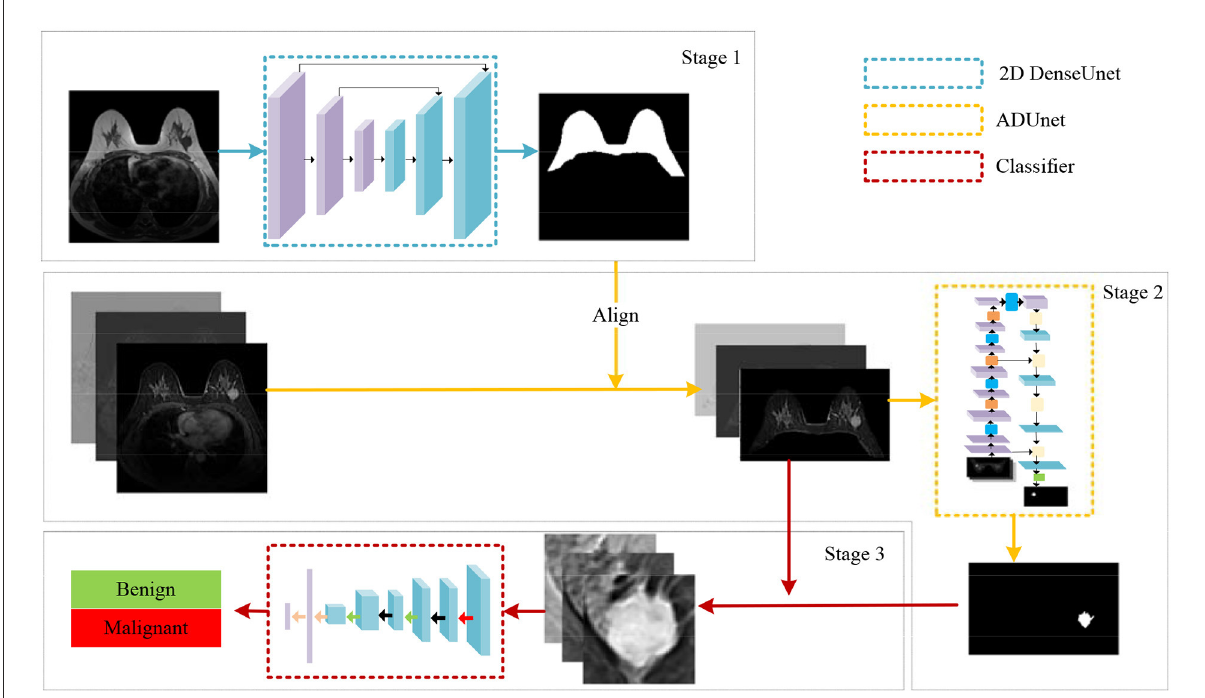
FIGURE2 An illustration of the proposed algorithm for automatic breast diagnosis on multi-series